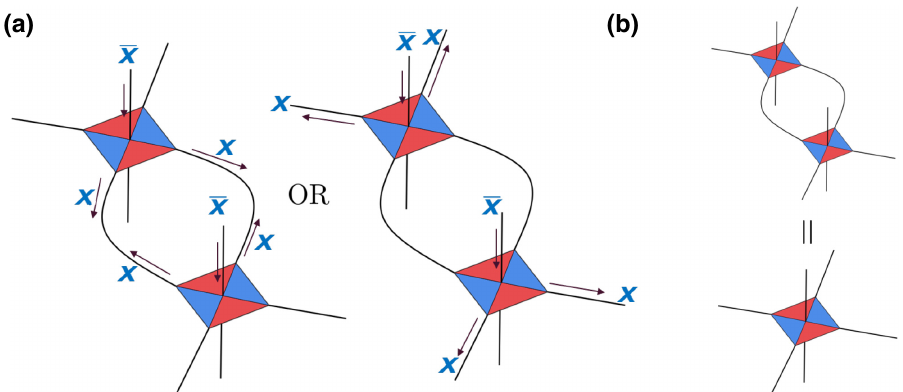
Figs. 4(b) and 4(c) as an (encoding) isometry, which maps one qubit to five